Question: Generate an informative caption for the figure above.
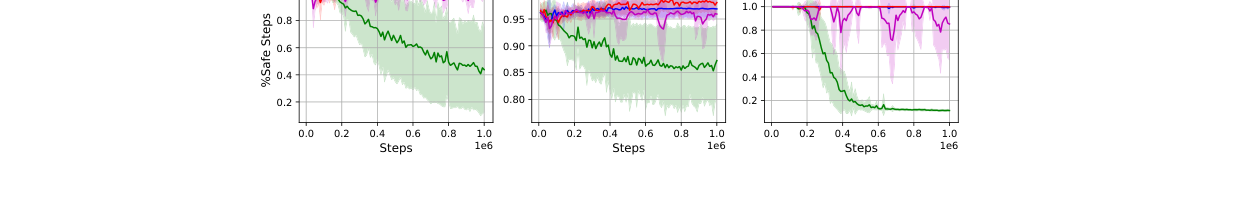
Answer: MuJoCo Results - Reward and Safety Performance